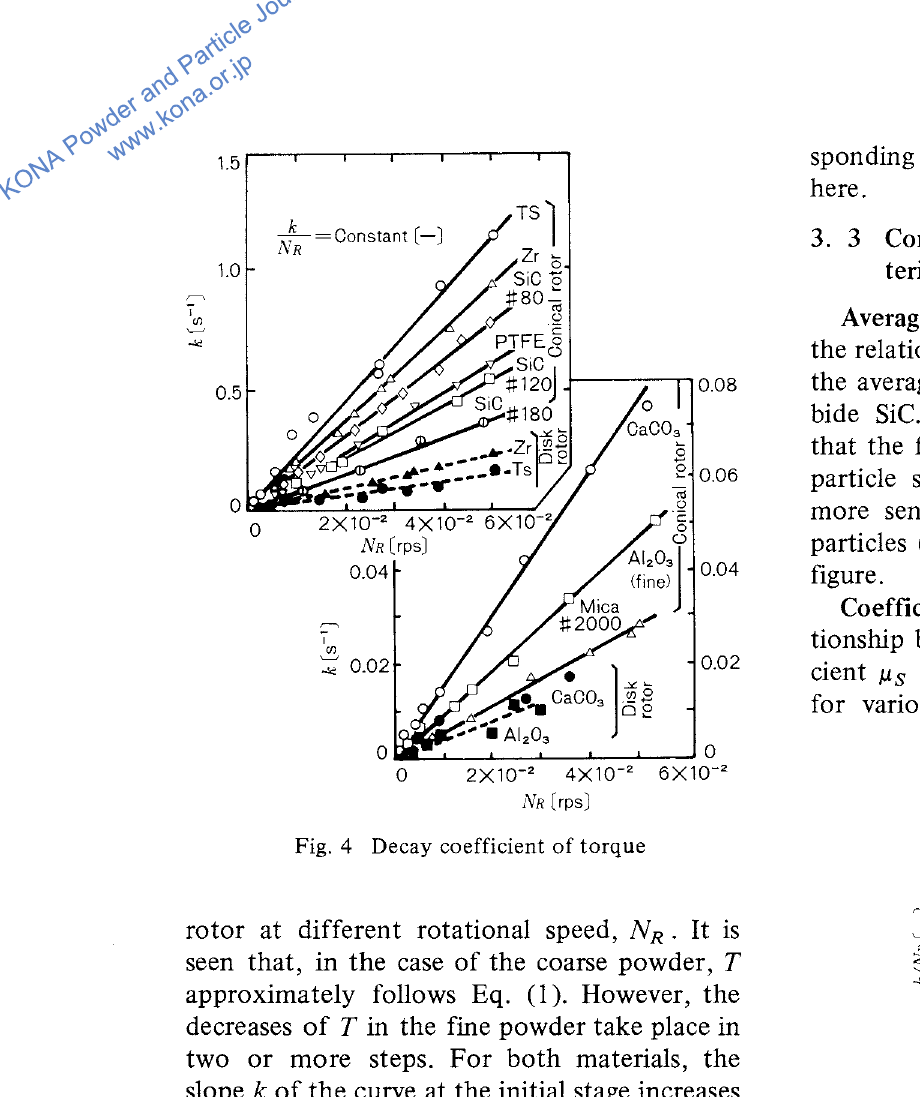
Fig. 4 Decay coefficient of torque